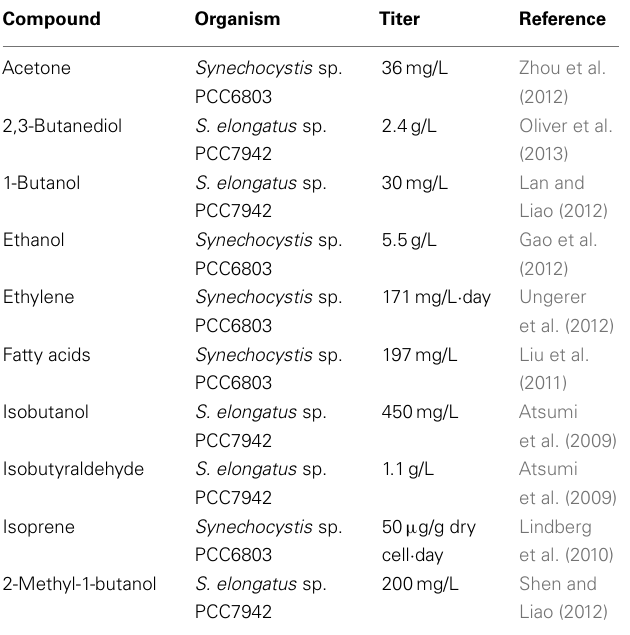
Table 1 |Titers for various biochemicals.